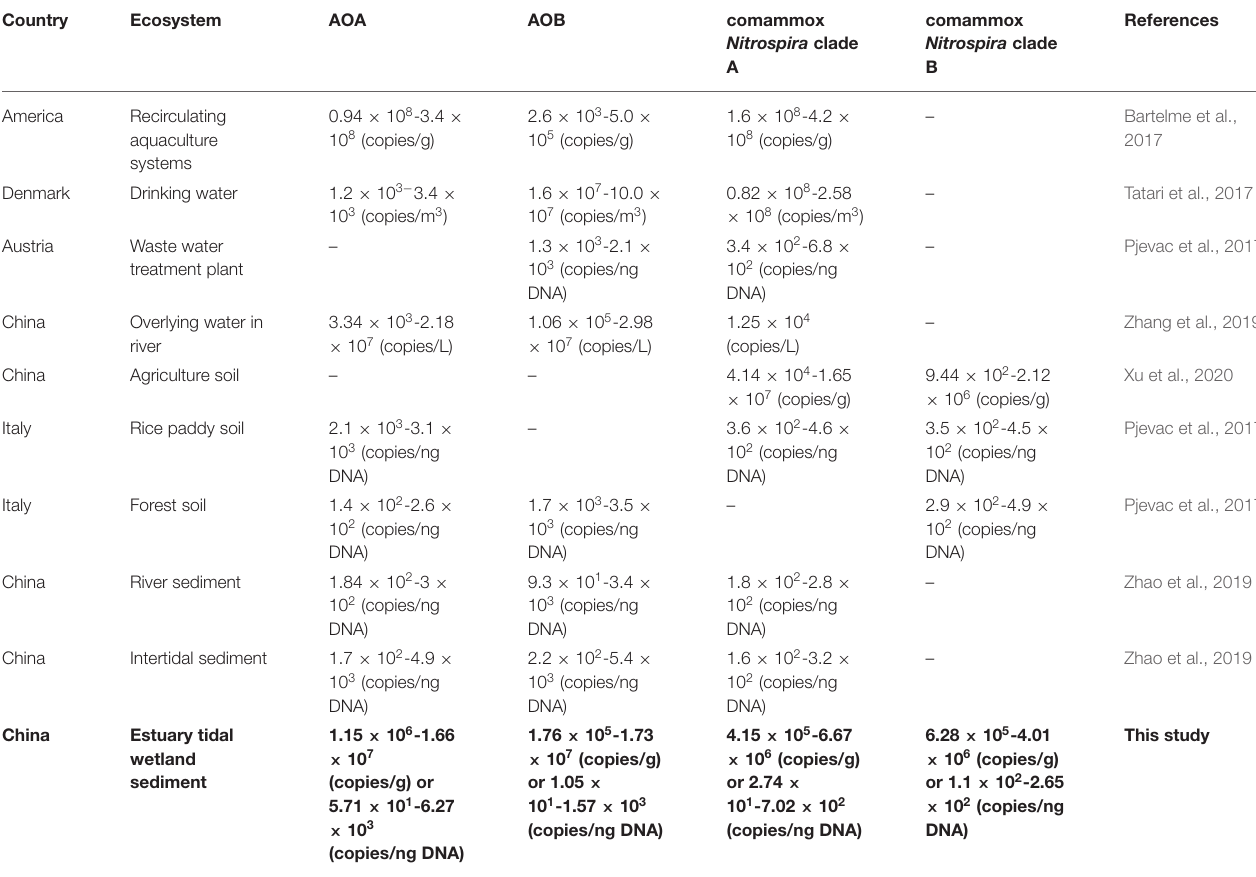
TABLE 1 | Distribution of ammonia-oxidizers in different